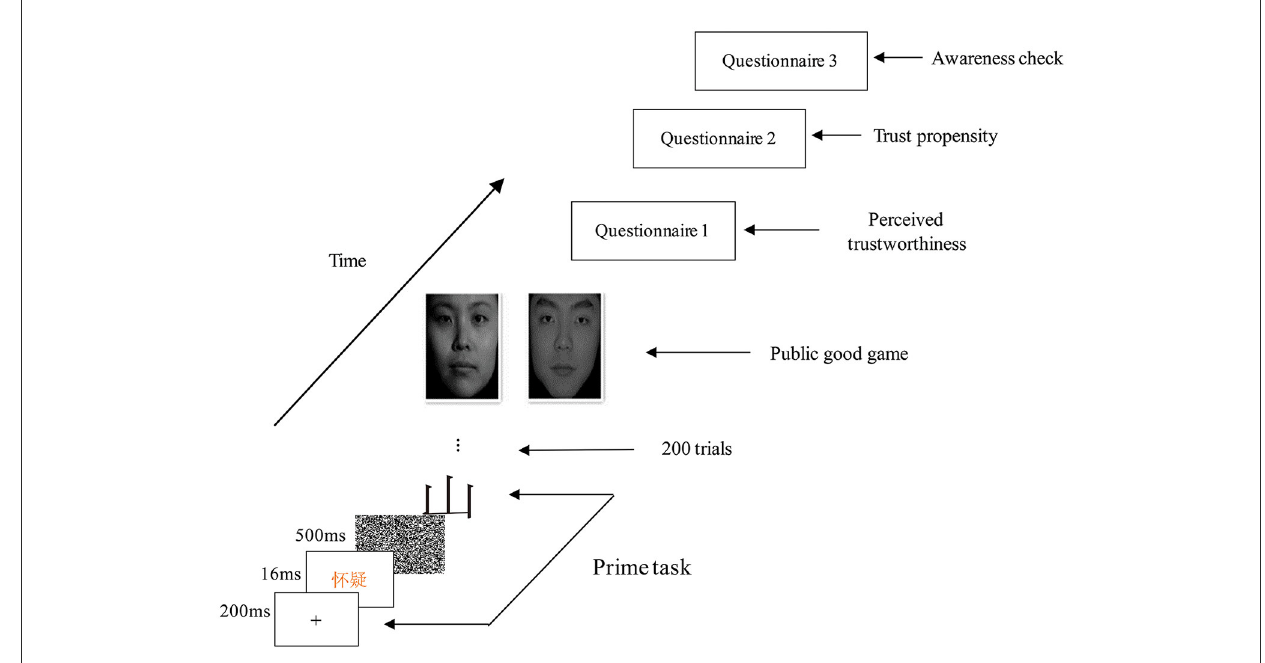
FIGURE1 Illustration of the whole process.